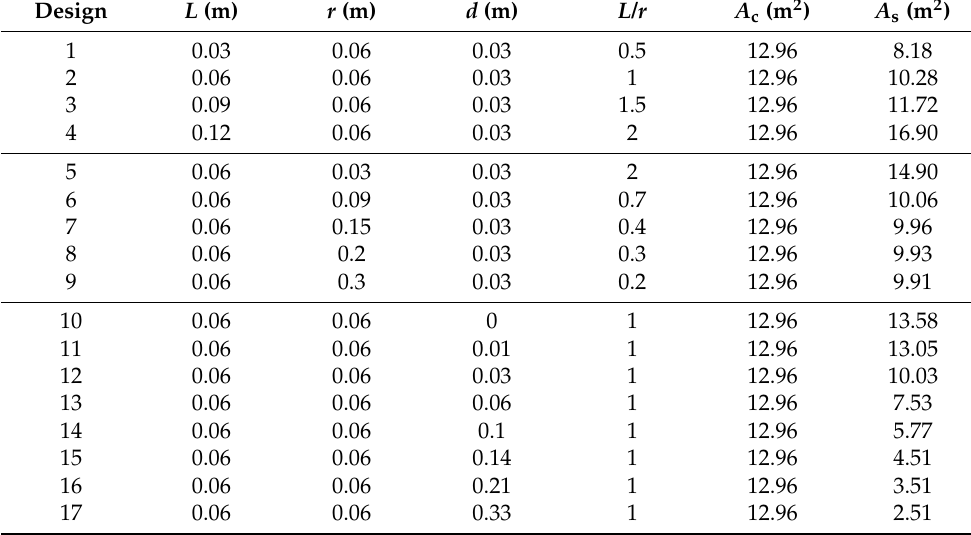
Figure 1. Schematic diagram of the panel and design parameters. Thirty-five designs were created and compared to show the effect of each parameter. The values of each parameter in each case are summarized in Table 2. The panel curvature width ( L ) was altered from 0.03 to 0.12 m, the panel curvature radius ( r ) was altered from 0.03 m to 0.3 m, the void distance (d) was altered from 0 m to 0.33 m, and the panel cover area ( A c ) was altered from 7.58 m 2 to 12.96 m 2 . Accordingly, the L / r ratio varied from 0 to 2, and the panel surface area ( A s ) varied from 2.51 m 2 to 16.90 m 2 . When the effect of one independent parameter was examined individually, the other three parameters were held constant. Two dependent parameters— L / r ratio and A s —were investigated with different panel width and curvature radius values, while the coverage area and void distance were the same. Additionally, four replenished designs were proposed for optimization and verification. Table 2. Design of